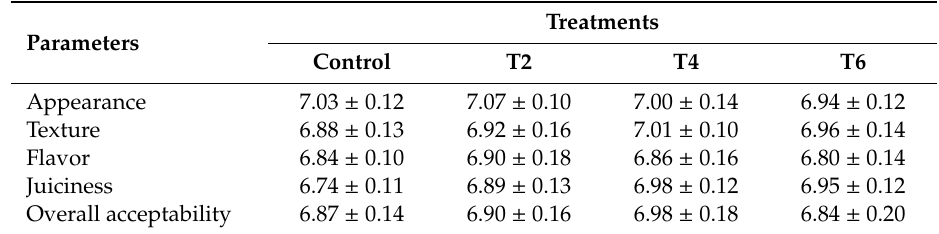
Table 4. E ff ects of enoki mushroom stem waste (MSW) powder on the sensory characteristics of goat meat nuggets ( n = 30).